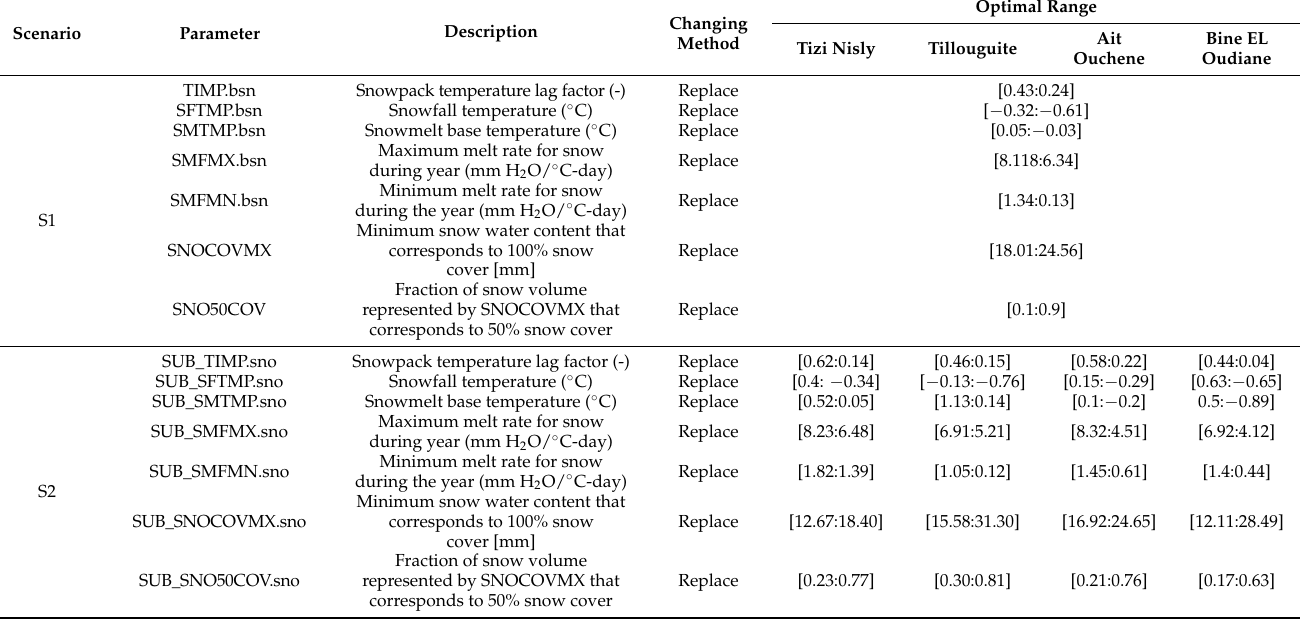
Table A2. Calibrated SWAT snow parameters and their optimal